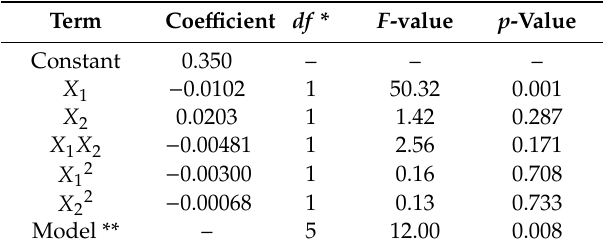
Table 3. Significance of the response surface model and the coefficients for the methane yield. Term